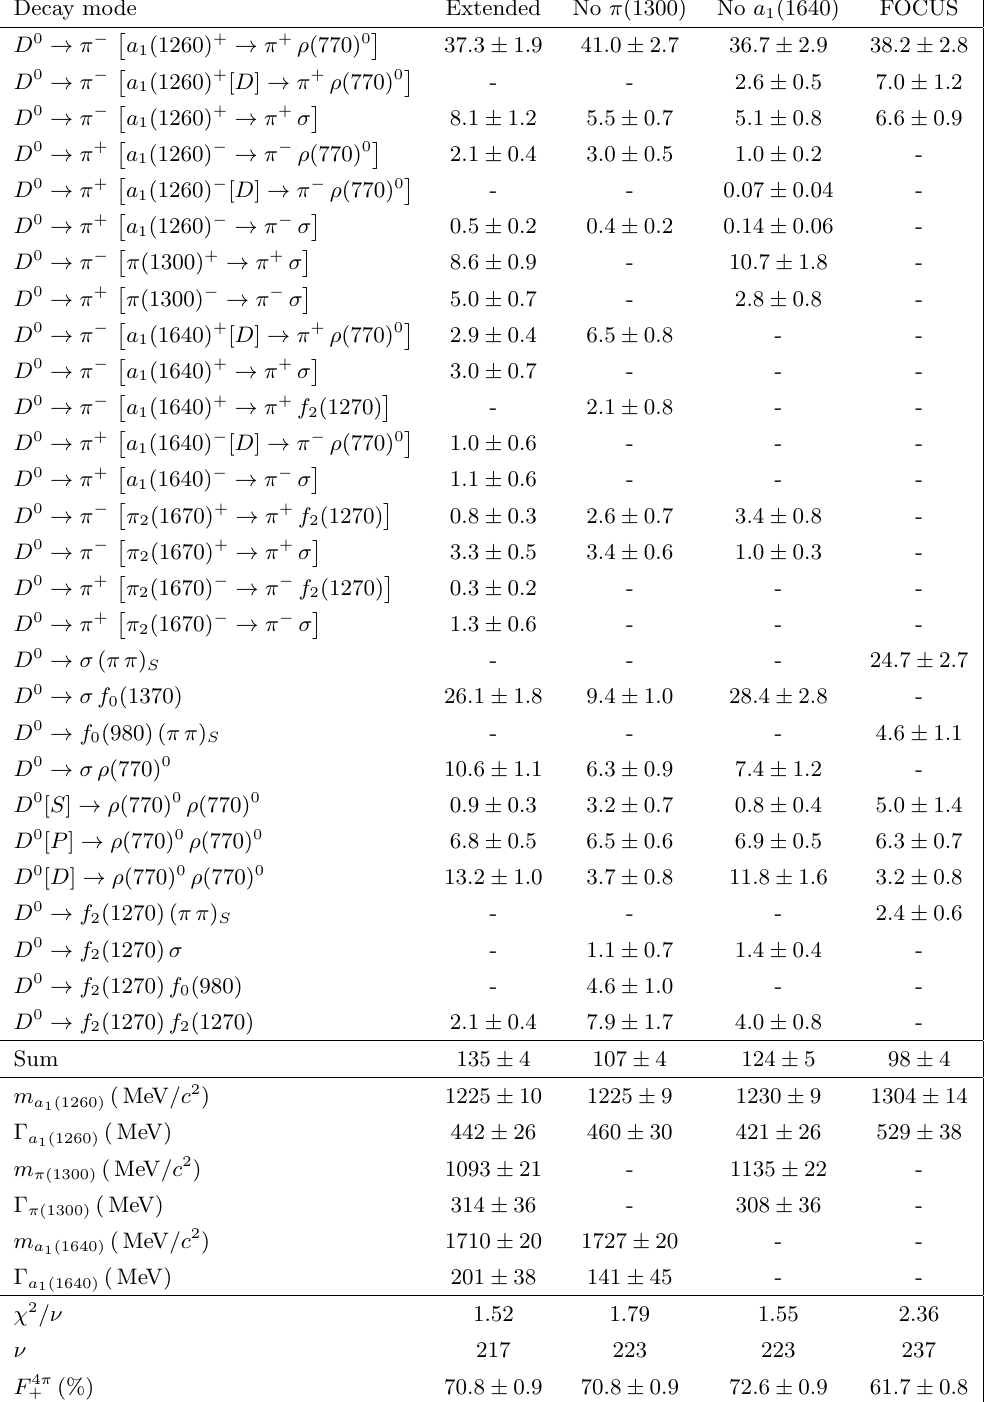
Table 18 . Fit fractions in percent for each component of speci(cid:12)c alternative models for D 0 ! (cid:25) + (cid:25) (cid:0) (cid:25) + (cid:25) (cid:0) . Resonance parameters, F 4 (cid:25)